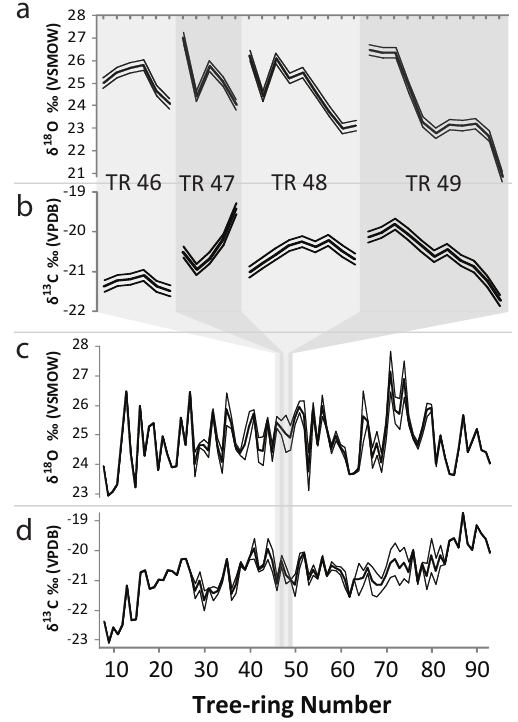
Figure 1. Subannual and annual-resolution time series records of tree-ring cellulose δ 18 O and δ 13 C. Subannual resolution (a) δ 18 O record, and (b) δ 13 C record, of four tree rings (TR 46–49). Lines above and below the measured values (bold center lines) show the analytical uncertainty (0.14‰ for δ 13 C, 0.23‰ for δ 18 O). Annual resolution (c) δ 18 O record, and (d) δ 13 C record ( n = 86). Bold lines show mean isotope values of annual-resolution study, thin lines above and below mean values show minimum and maximum iso- tope values of successfully crossdated tree-ring transects (TR 28– 63,